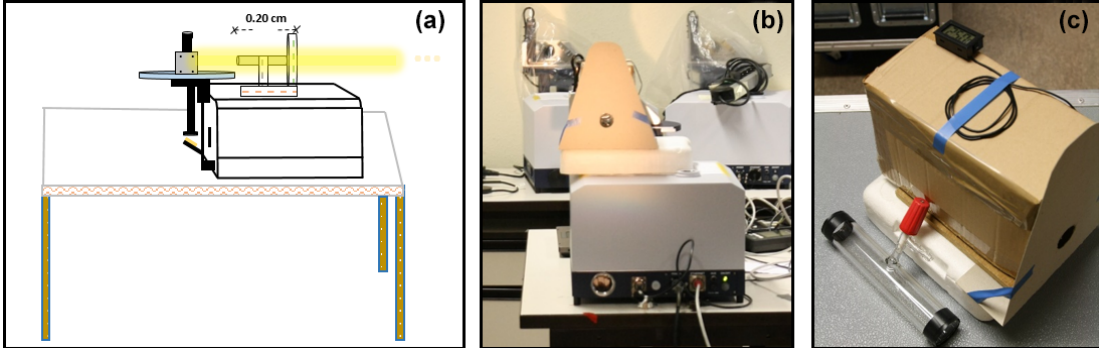
Figure 5. The set-up of the cell measurements and the cell components used in this study are shown in (a) , (b) and (c) , respectively.